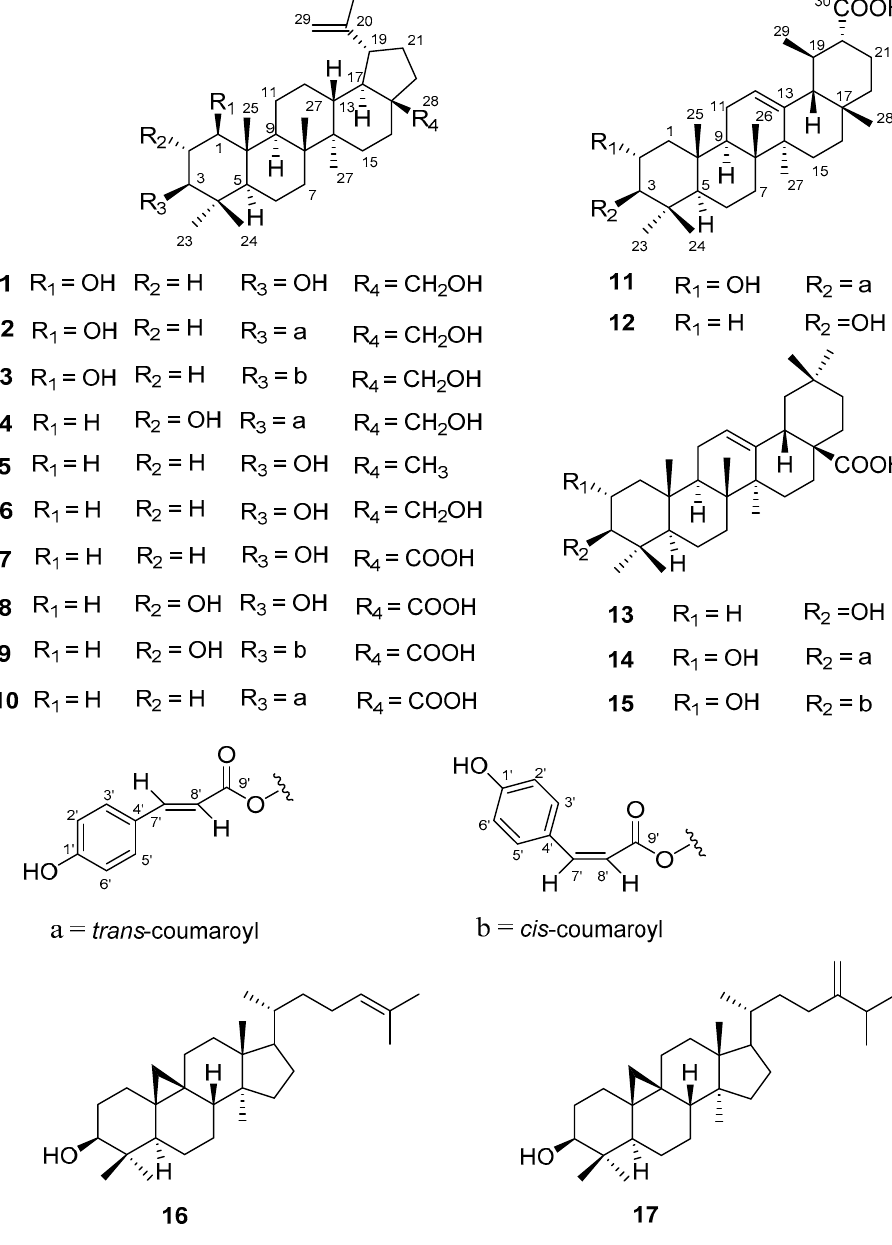
Figure 1. Structures of compounds 1 – 17 .